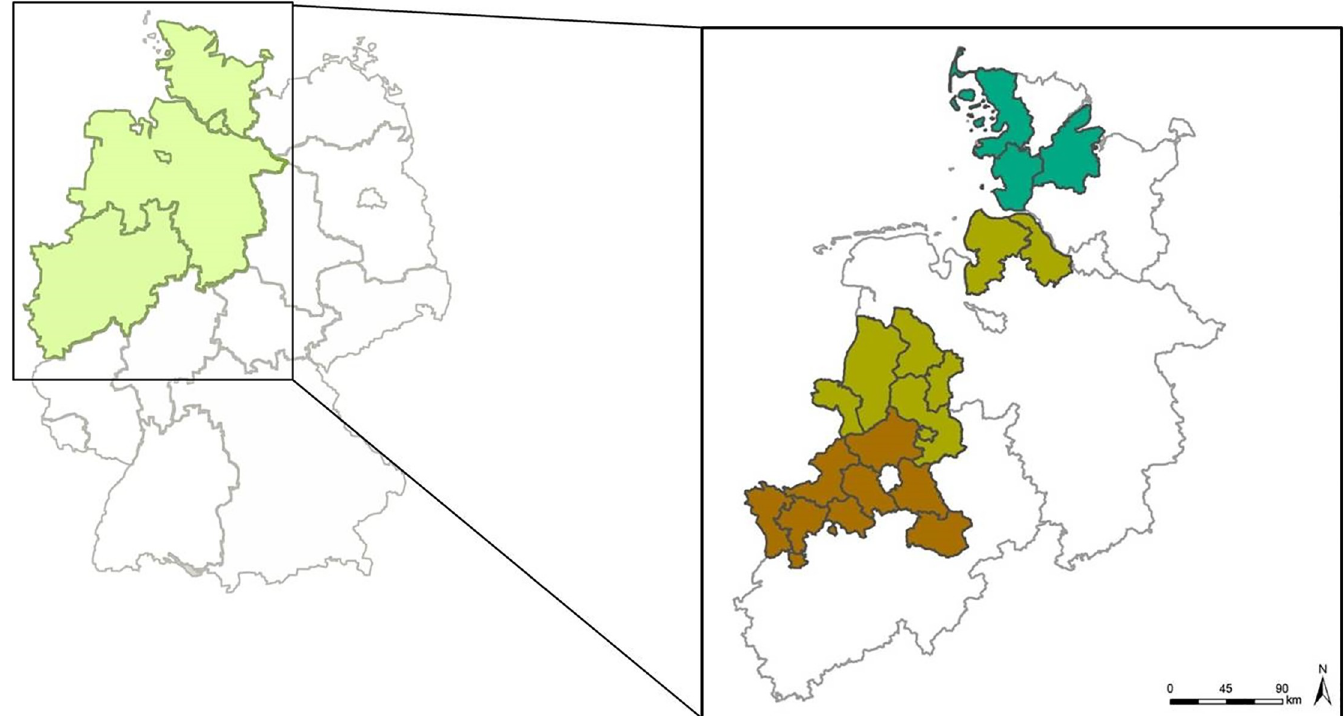
Fig 1. Map of Germany with the study areas Lower Saxony, North Rhine-Westphalia and Schleswig Holstein, © GeoBasis-DE / http://www.bkg.bund.de, 2019.